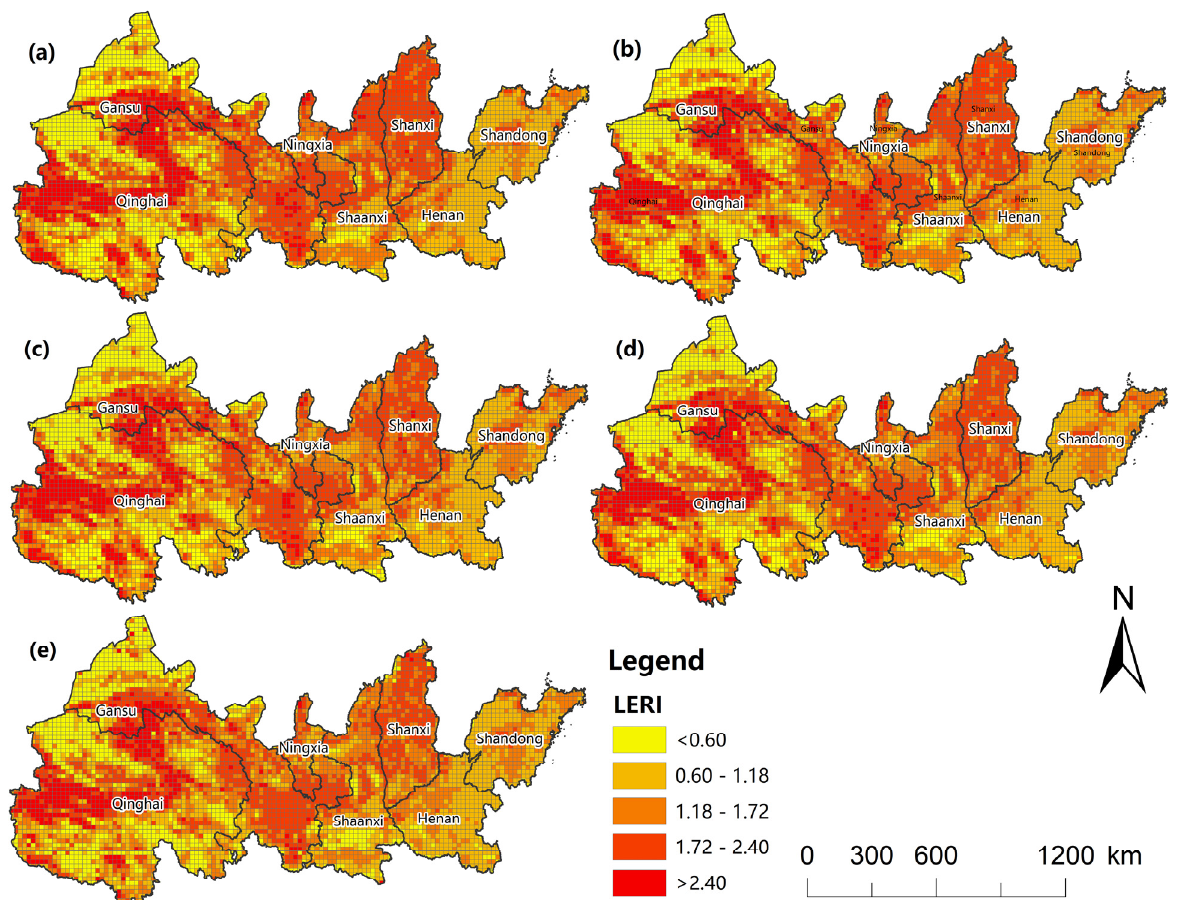
Figure 6. Maps of landscape ecological risk levels in 2000 ( a ), 2005 ( b ), 2010 ( c ), 2015 ( d ), and 2020 ( e